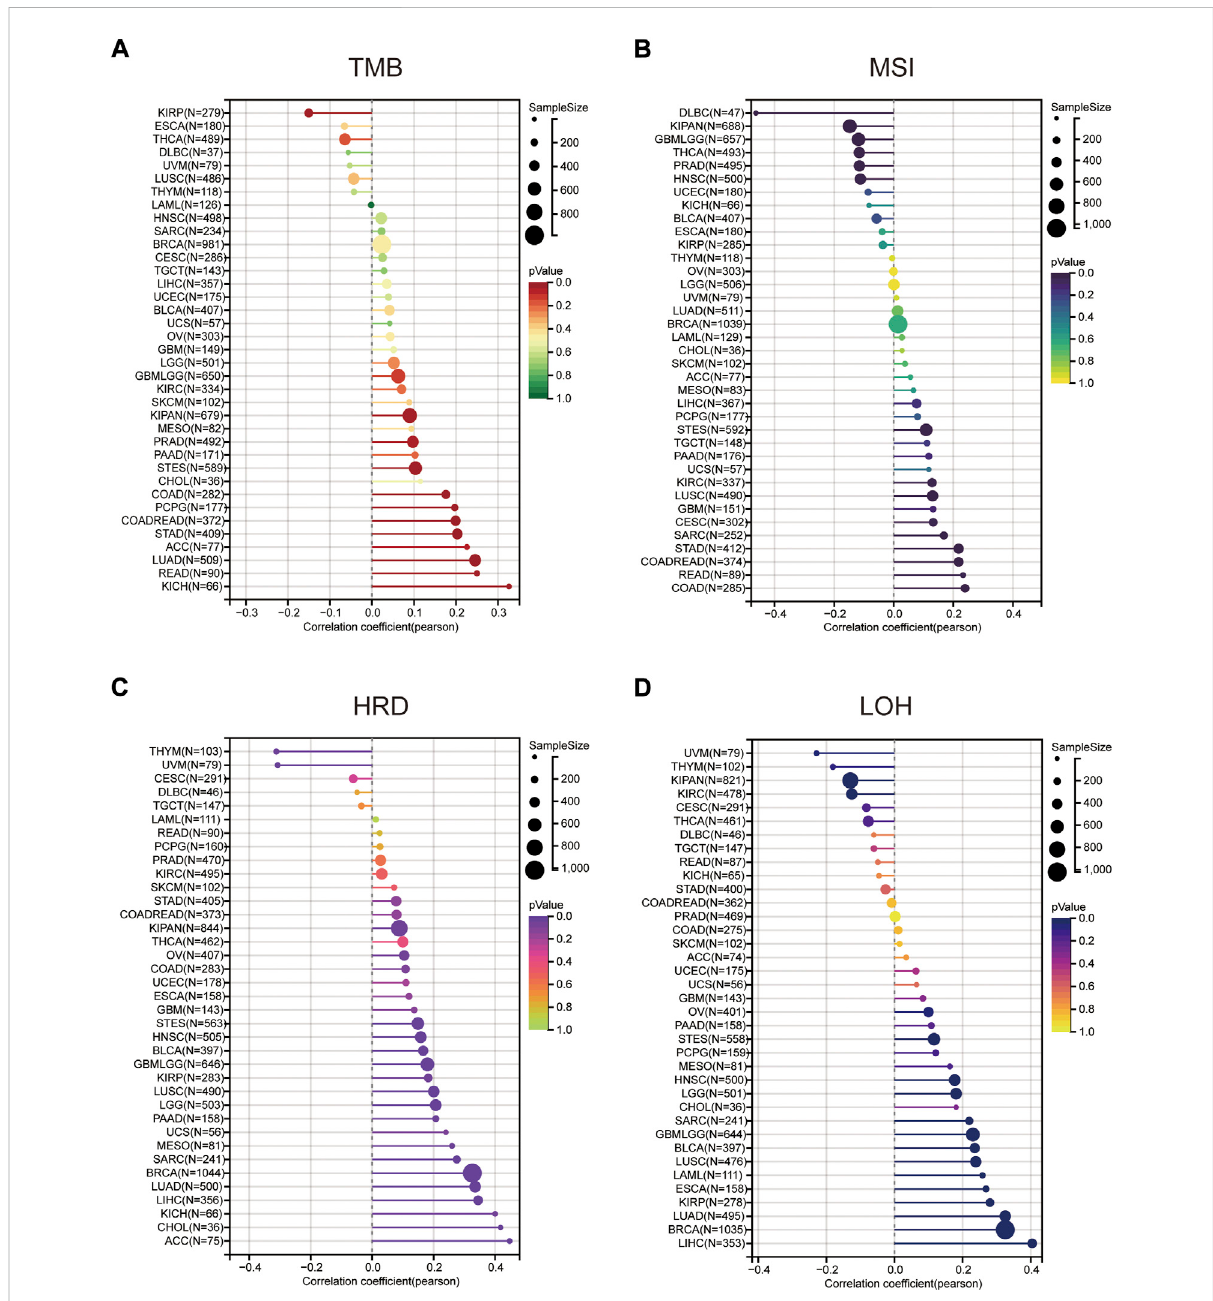
FIGURE 4 Thecorrelationbetweenmethylmethanesulfonate-sensitivity protein22-like (MMS22L)expressionandgenomicheterogeneityinpan-cancer. (A) Spearman correlation analysis of tumor mutational burden and MMS22L mRNA expression. (B) Spearman correlation analysis of microsatellite instability and MMS22L mRNA expression. (C) Spearman correlation analysis of homologous recombination de fi ciency and MMS22L